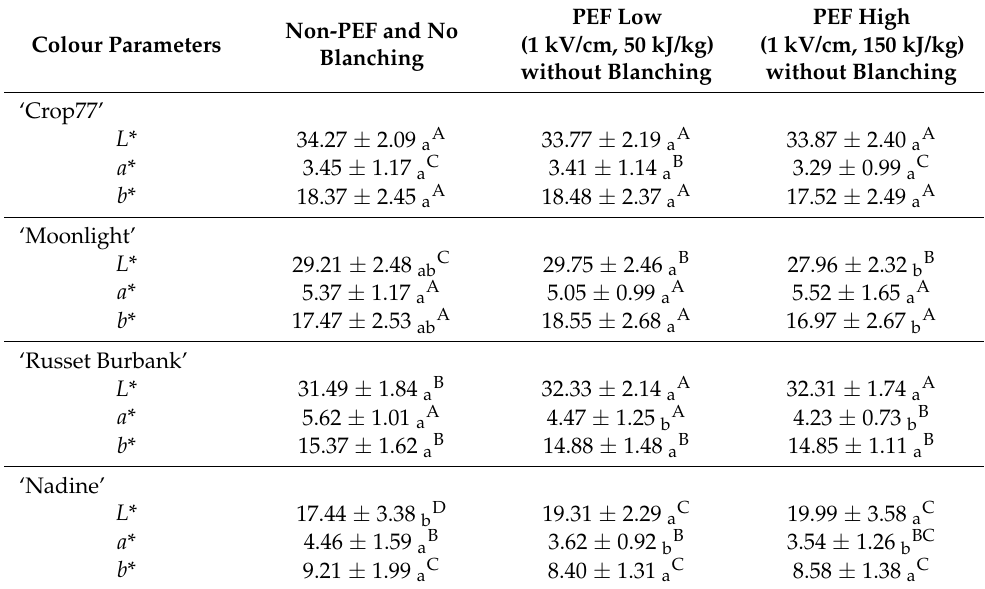
The data are presented as mean ± standard deviation ( n = 15 measurements, 3 measurements from 5 independent potato tubers per treatment). Means in the same row for each cultivar not sharing the same lowercase letter in subscript are significantly different at p < 0.05 between untreated and PEF-treated potatoes based on one-way ANOVA and Tukey’s post hoc test. Means in the same column for each colour parameters not sharing the same uppercase letter in superscript are significantly different at p < 0.05 between cultivars of the same treatment based on one-way ANOVA and Tukey’s post hoc